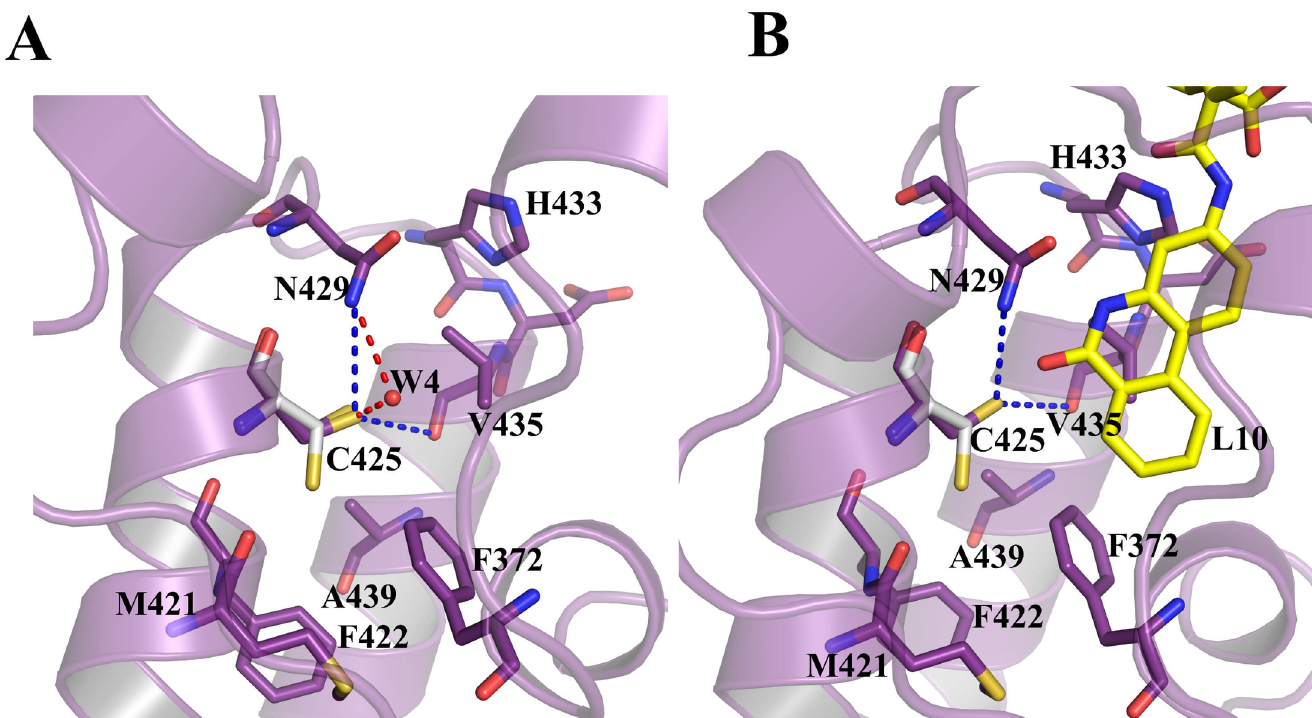
Fig 6. Water molecule hydrogen bonded to C425 and N429 in apo- form. (A) Direct (blue) and a water mediated (red) hydrogen bond between C425 and N429 in the apo- form. (B) No water is observed in the same position in the BD2-L10 complex. Residues corresponding to both apo- form and BD2-L10 are represented in purple. The C425 corresponding to BD2-H4K5ac is shown in grey. The ligand and the interacting residues are shown as sticks. Water molecules are shown as spheres. The hydrogen bonds are shown as broken lines.